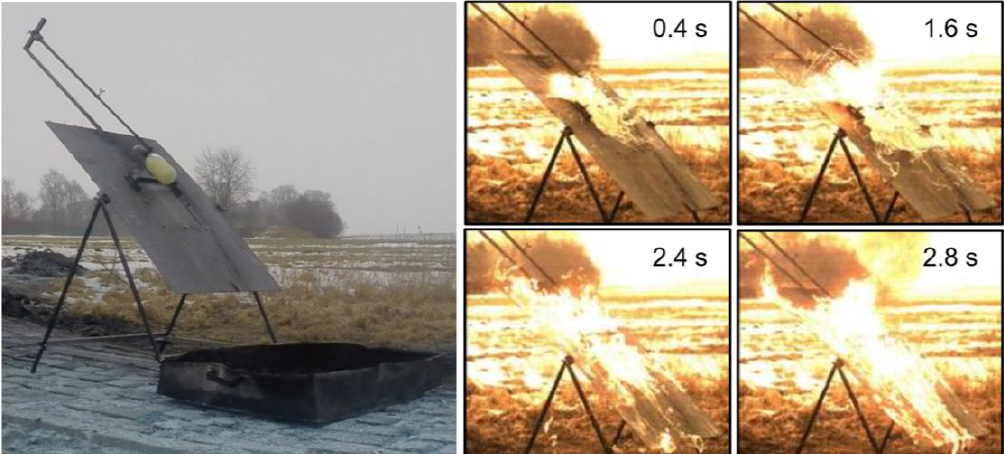
Figure 1. Steel sample holder with a 45° installed 330 mm × 330 mm carbon fiber-reinforced polymers (CFRP) panel used for the fire tests, and images of a high-speed camera representing the application of an improvised incendiary devices (IID).